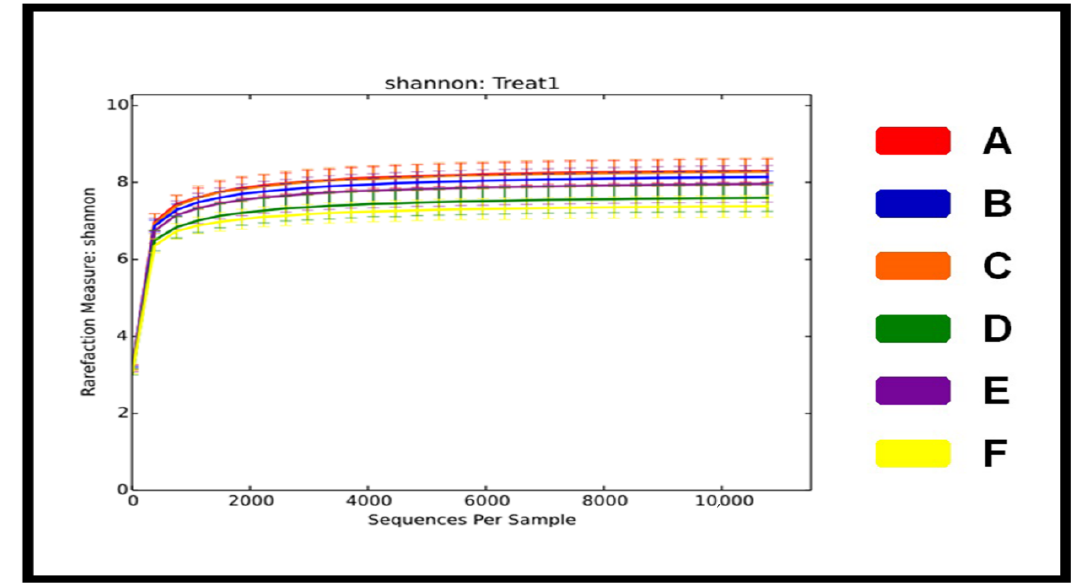
Figure 5. Rarefaction curve sequences indicating the complexities of the microbial communities in the cecal samples of laying birds. Corn diet supplemented with (A) enzyme-a, (B) enzyme-b and (C) enzyme-c and wheat diet supplemented with (D) enzyme-a, (E) enzyme-b, and (F) enzyme-c.